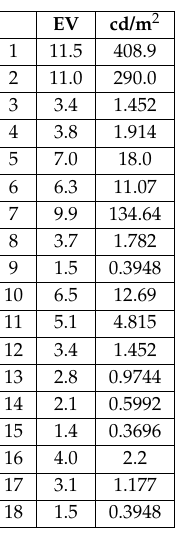
Figure 5. Luminance value